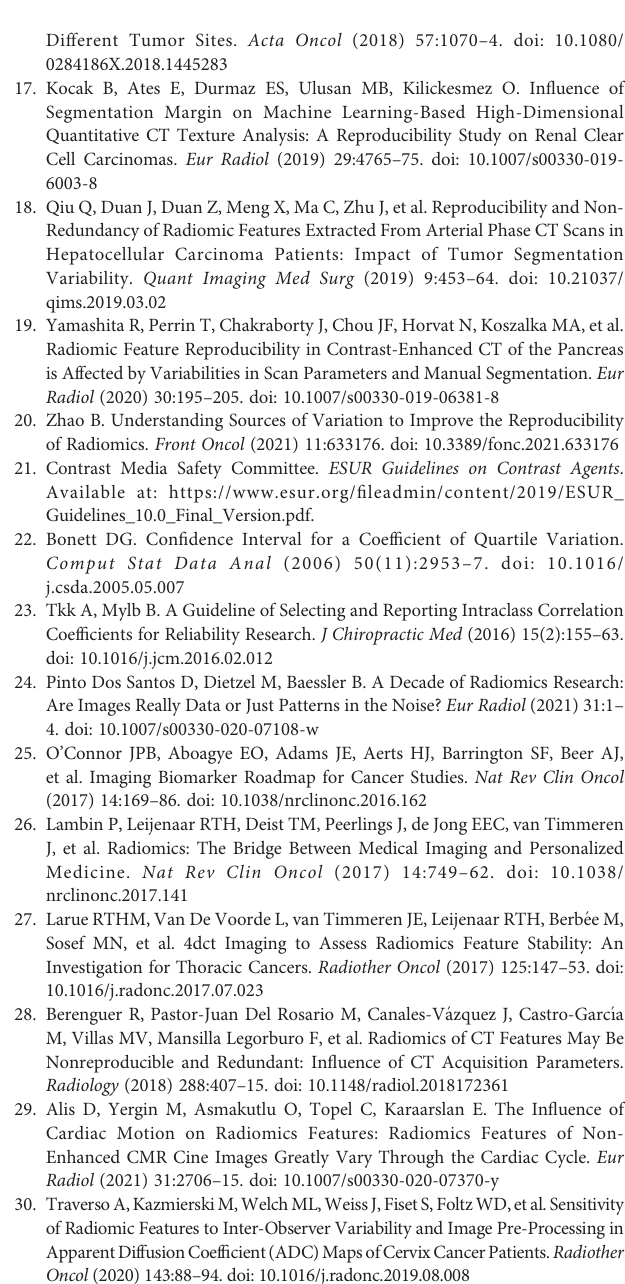
Supplementary Table 2 | The speci fi c radiomic feature with small variation and excellent